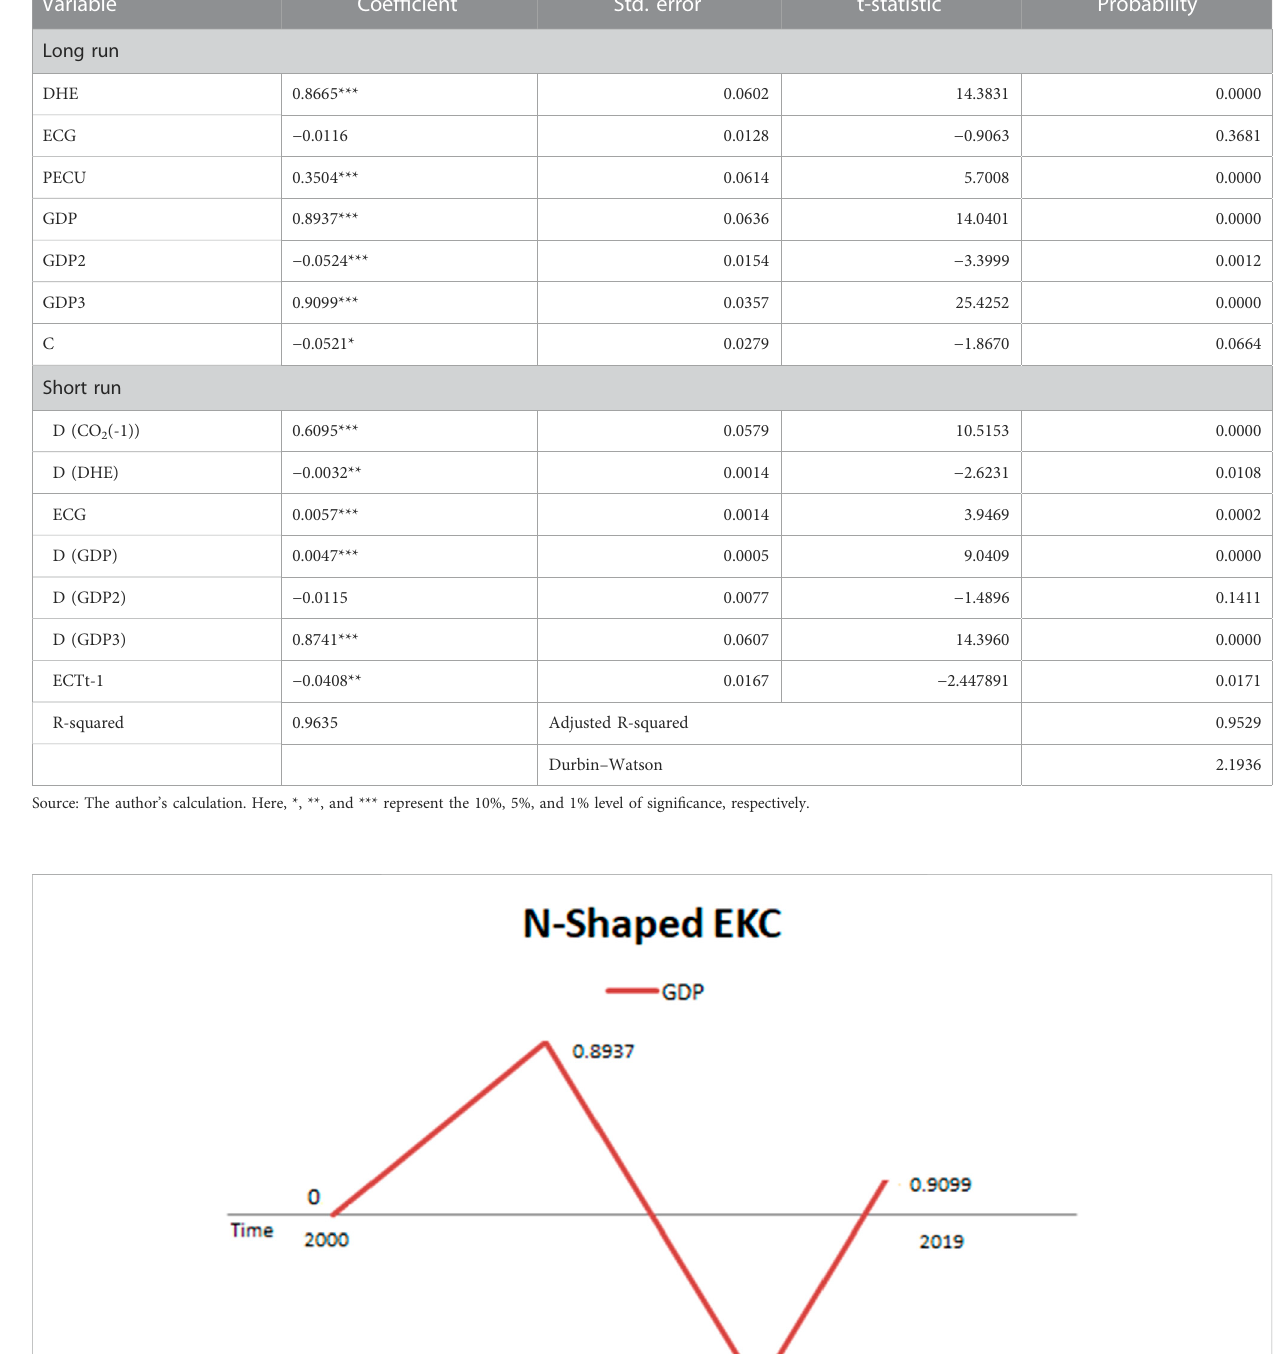
TABLE 4 Long-run and short-run dynamics of the study variables. Variable Coef fi cient Std. error t-statistic Probability